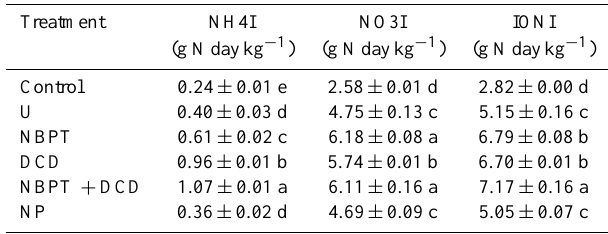
Table 5. Effects of urease and/or nitrification inhibitors and ni- trophosphate on soil ammonium (NH4I), nitrate (NO3I) and inor- ganic N (IONI)